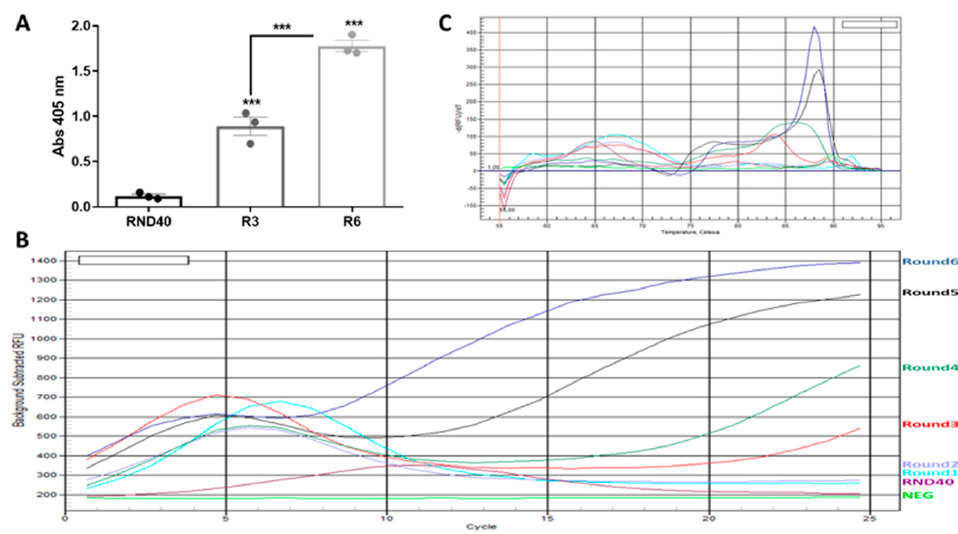
Figure 1. Study of selection evolution. ( A ) ELONA from rounds three and six. Plates with 100 ng/well (2.5 pmol/well) of HAT1 protein bound to them were incubated with 200 ng/well (80 nM) of either the starting population (RND40), round three (R3), or round six (R6) labeled with digoxigenin. The bars show the mean ± SEM. Data shown correspond to three independent experiments (*** p < 0.001 of R3 and R6 relative to the initial population, and of R6 relative to R3). ( B ) Real-time PCR and ( C ) melting curve of the initial population (RND40) and the six rounds of selection. The color legend matches the previous